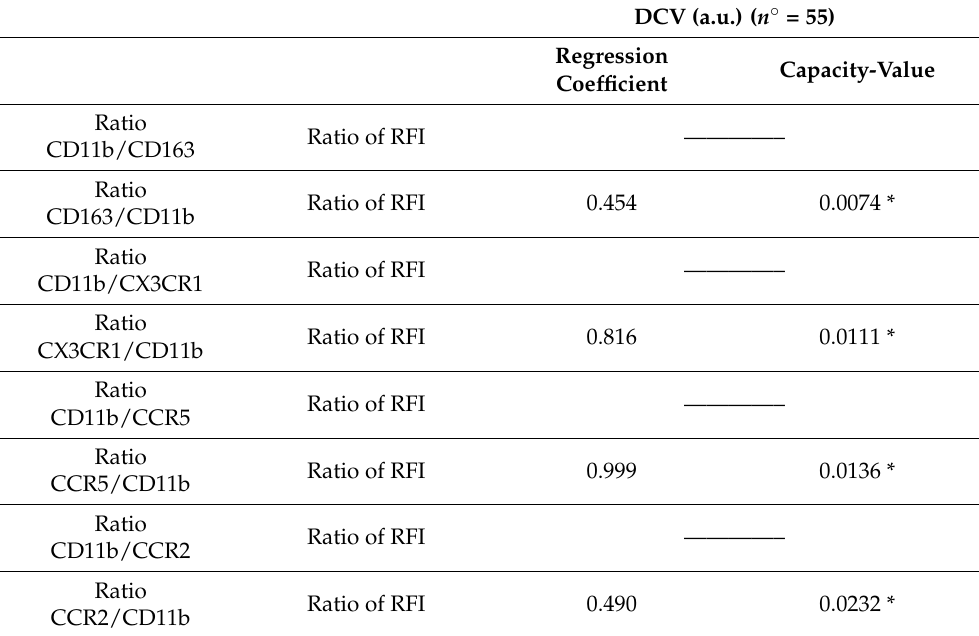
Table 5. Multiple regression of RFI ratio of opposite polarized monocyte markers and